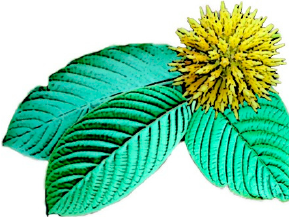
Figure 2. Leaves and flower of Mitragyna speciosa .